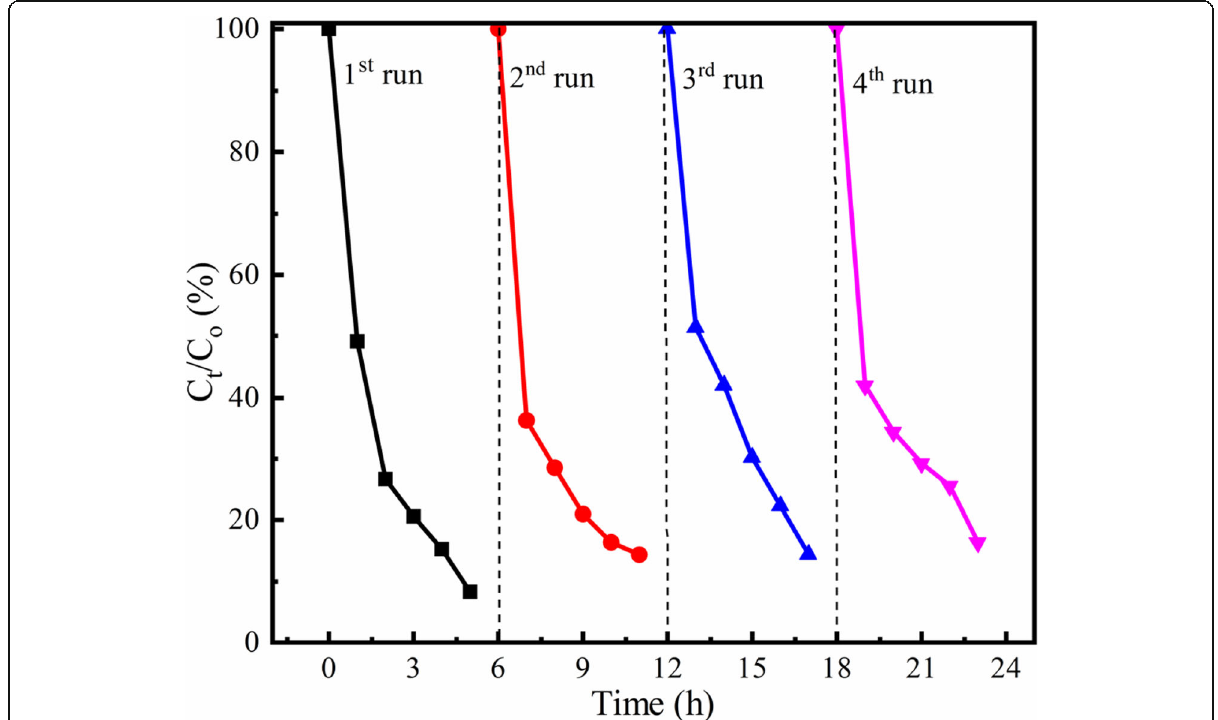
Fig. 12 Reusability test of the 1 wt% α -Bi 2 O 3 @g-C 3 N 4